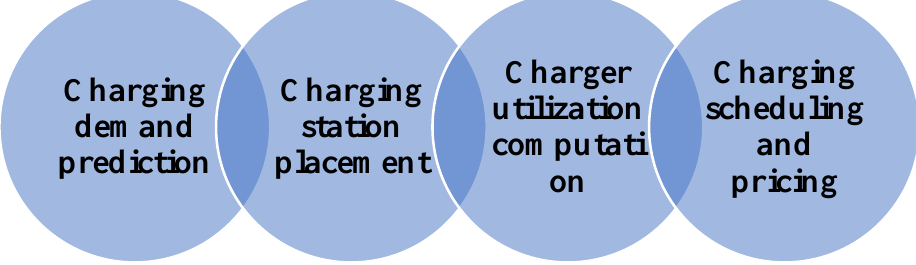
Figure 1. An overview of charging infrastructure